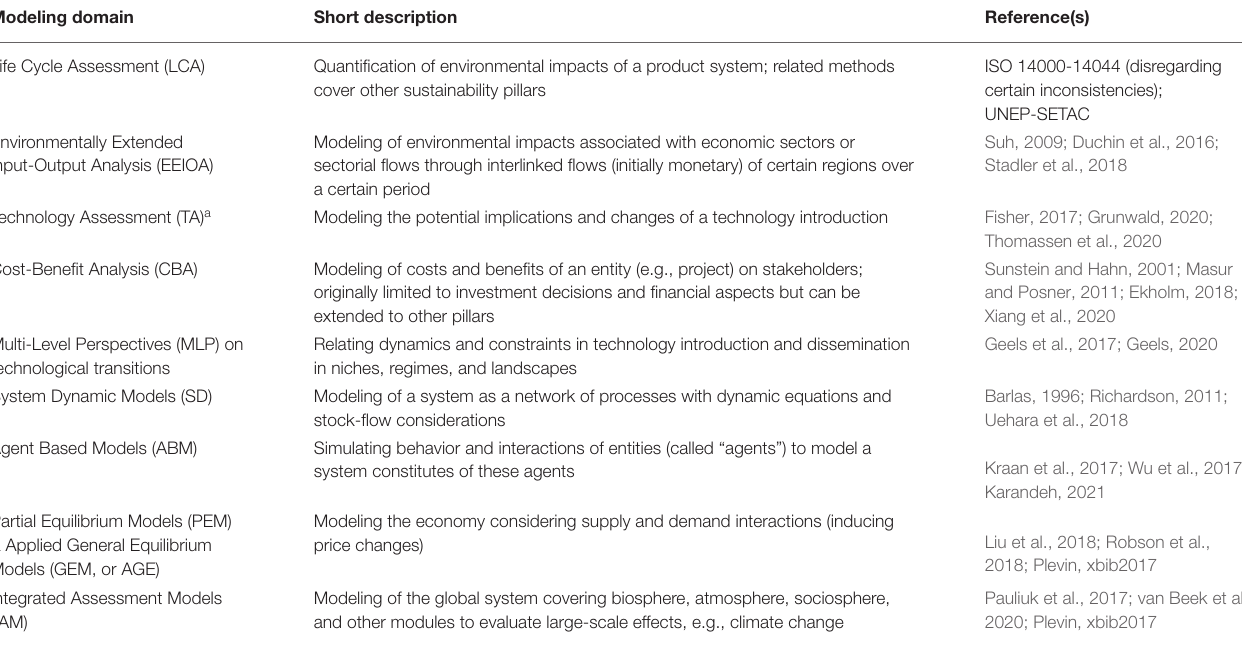
TABLE 1 | A collection of modeling domains that can focus on long-term decision support, and have been linked with LCA. Modeling